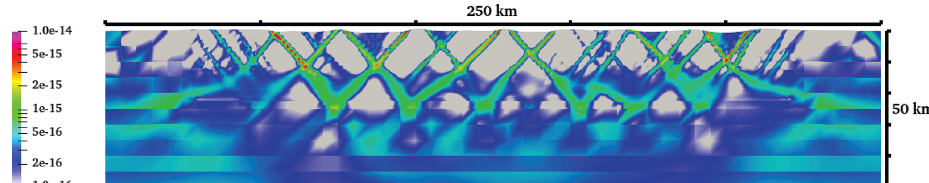
Figure B3. Cross section at y = 375km, showing the strain rate attribute through 10Myr of the model run. This location corresponds to the boundary between the weak and reference (north) domains. See Fig. 4c for a 10Myr snapshot. Screenshot taken at 10Myr.